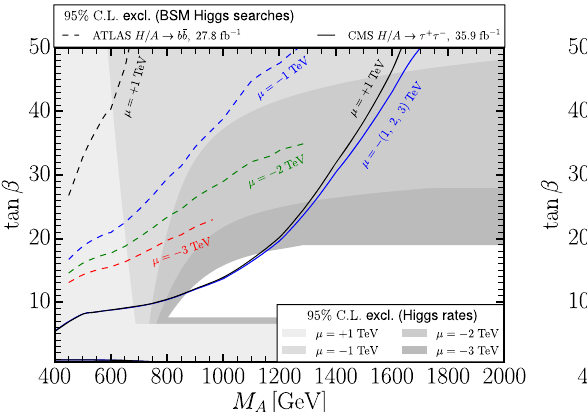
(μ = measurements (gray filled regions); right panel: contours for the lowest h acceptable value of the light-Higgs boson mass, M h = 122GeV (tak- ing into account a theory uncertainty of ± 3GeV), with the Higgs rate constraints (from the left panel)